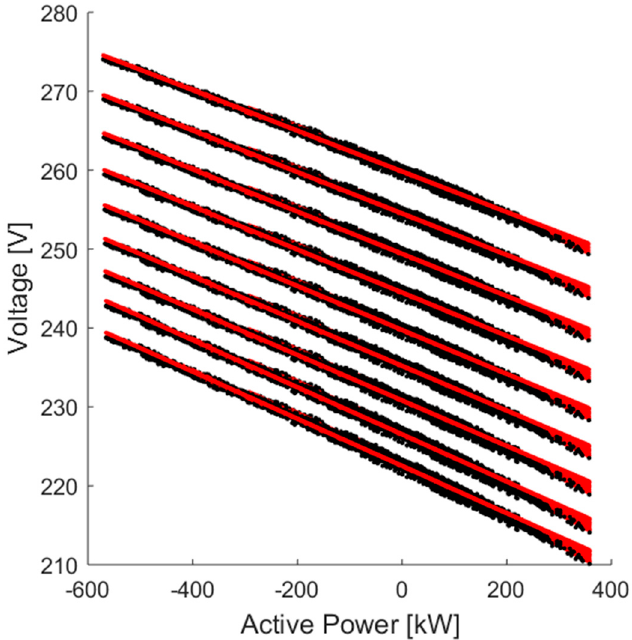
Figure 7. Active mean power drawn by transformer versus maximum voltage on the network considering all penetration levels (minute by minute).